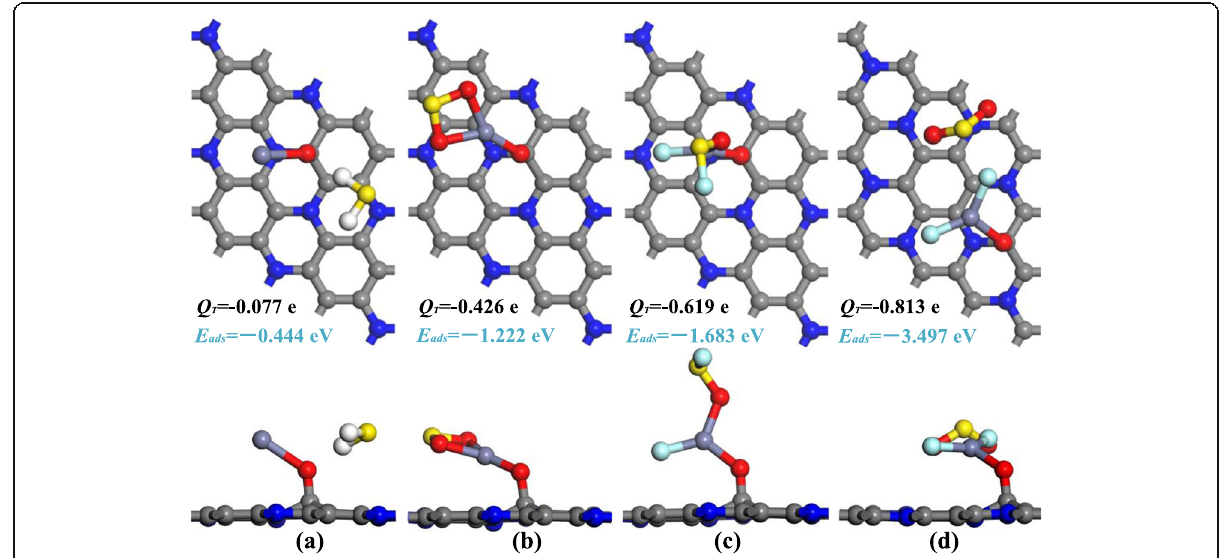
Fig. 4 The adsorption configuration of a H 2 S system, b SO 2 system, c SOF 2 system, and d SO 2 F 2 system